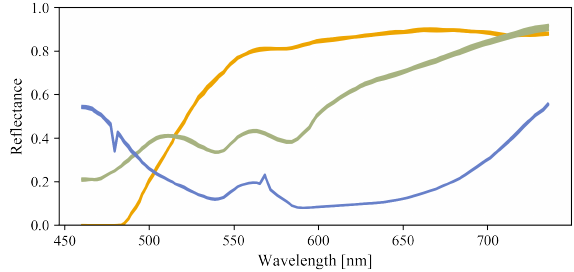
Figure 3. Spectra of anomalous pixels. These are randomly distributed to the test dataset, which has same dimensions as the training set has ( 50 × 50 × 100 ).